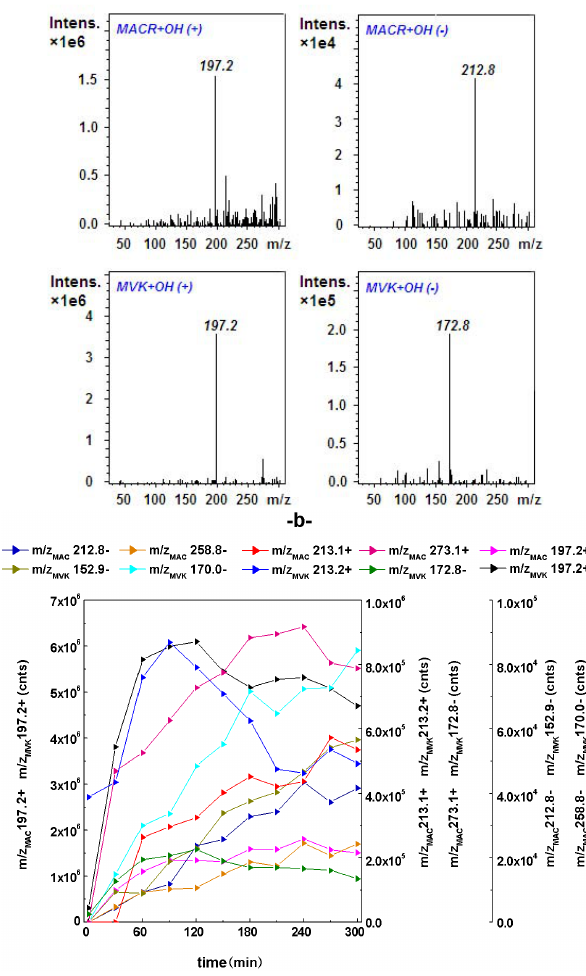
Fig. 3. Characteristics of high-molecular-weight ions (HMWs): (a) Selected HPLC-MS spectra of HMWs (The retention time of HMWs formed from MACR–OH reactions in positive and negative mode is ∼ 3–5 and ∼ 2–4min, respectively. The retention time of HMWs formed from MVK–OH reactions in positive and negative mode is ∼ 3–5 and ∼ 2–4min, respectively.); (b) Evolution of se- lected HMWs from MACR/MVK–OH